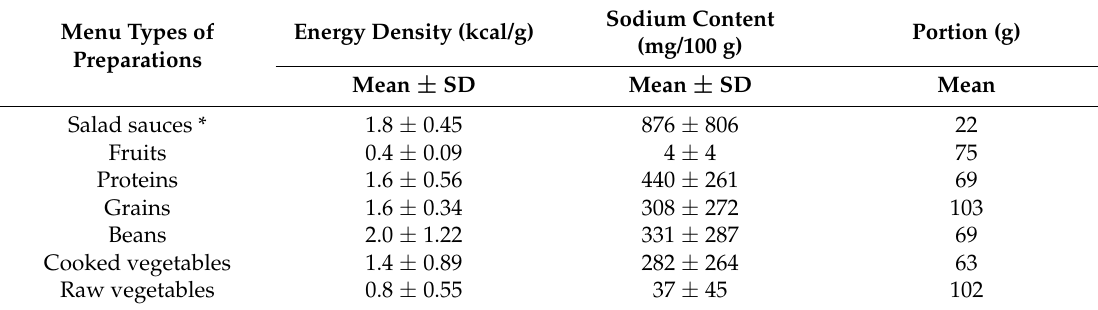
Figure 2. “Brazilian healthier lunch plate” based on a percentage of total energetic value. Table 2. Average energy density, sodium content and portion weight of the preparations of a food service unit.